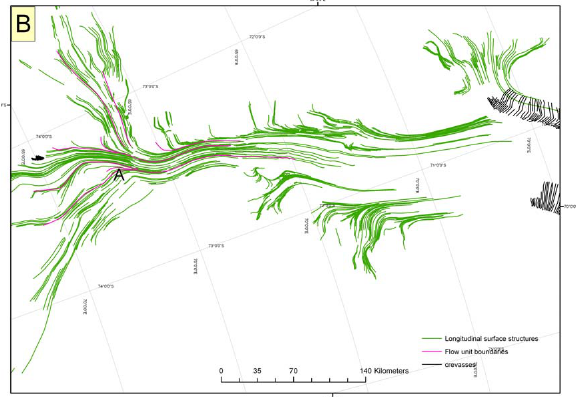
Figure 3B. Interpretation of key surface structures. Point A indicates development of longitudinal surface structures in the accumulation area of the glacier. Point B indicates the zone where two individual outlet glaciers converge, and Point C indicates uninterrupted and persistent longitudinal surface structures where an outlet glacier turns sharply around a bedrock obstacle. Point D indicates develop- ment of longitudinal surface structures where two glaciers converge around a bedrock